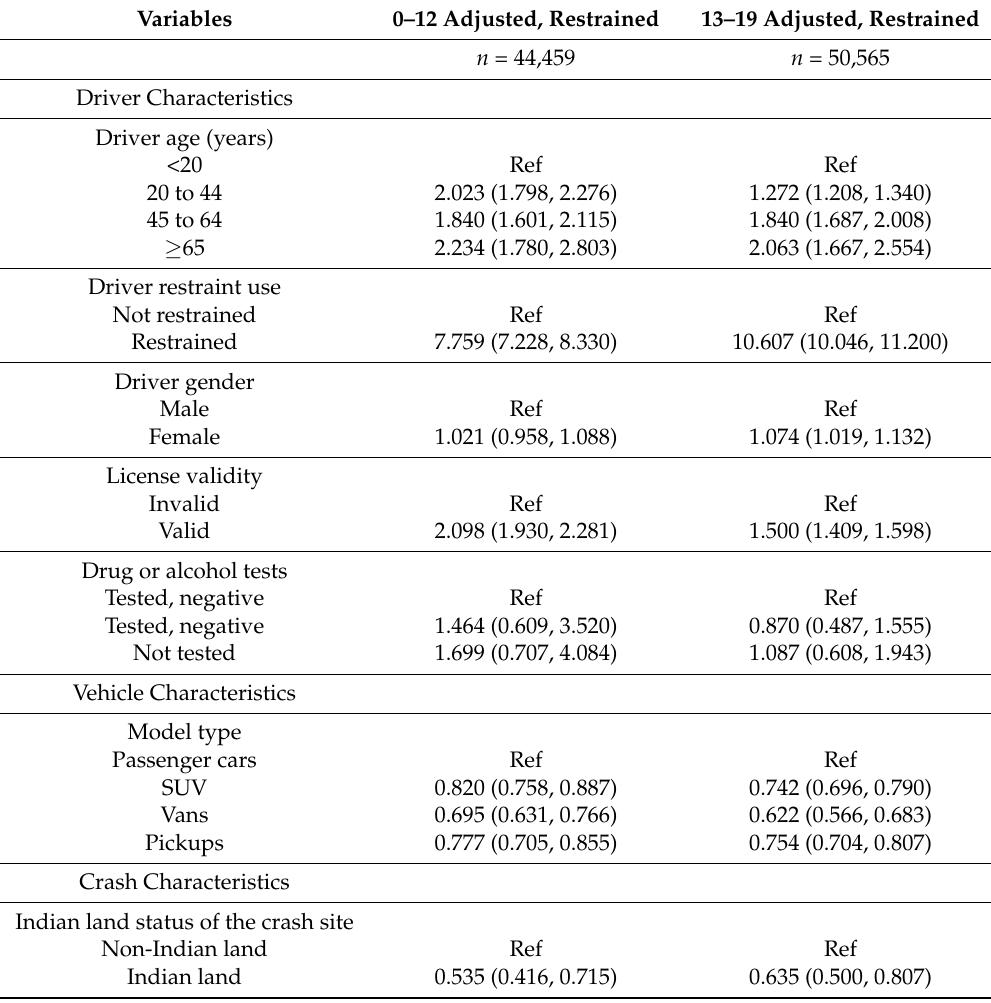
Table 2. Adjusted ORs (95% CIs) for infant, child and teen being restrained in the states with federally recognized Indian lands, FARS 2000–2014, categorized by passenger ages 0–12 and 13–19